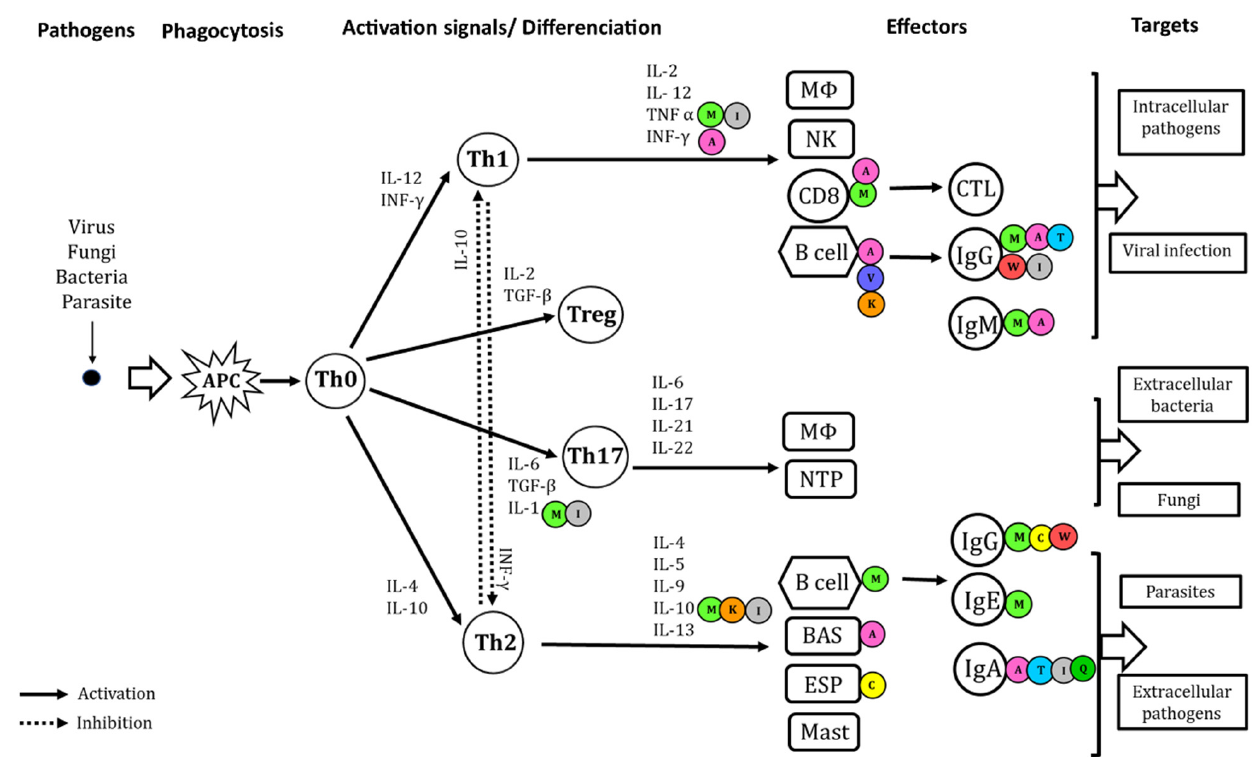
Figure 4. Amino acids suggested role in the host (mainly poultry) immune response against pathogens. Abbreviation: intracellular and extracellular antigens; ACP, antigen-presenting cells, generally dendritic cells; Th0, naive T helper cell carrying CD4 marker; Th1, Th2, helper T cells; Treg, regulatory T cell; IL, interleukin; IFN γ , interferon γ ; IFN α , interferon α ; TGF- β , Transforming growth factor β ; TNF α , tumor necrosis factor α ; M Φ , macrophage; CD8, CD8 T cell carrying CD8 maker; CTL, cytotoxic T cells; B cell, B lymphocytes; NK cell, natural killer cell; NTP, neutrophil; ESP, eosinophil; BAS, basophil; Ig, immunoglobulin; Mast, mastocyte. Impacts of amino acids.